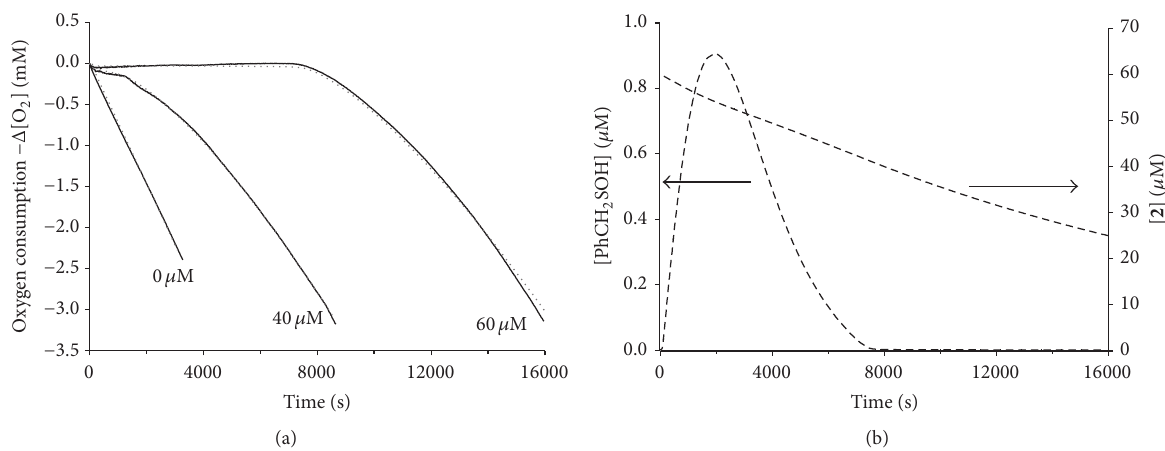
Figure 4: Analysis of autoxidation traces by the Gepasi software. (a) Experimental (solid lines) and simulated (dotted lines) O 2 consumption during the autoxidation of cumene in the presence of variable amounts of thiosulfinate ( 2 ). (b) Variations of the concentration of thiosulfinate ( 2 ) and sulfenic acid ( 3 ), obtained by simulation based on kinetic data determined in (a) at the concentration of 60 𝜇 m. Reprinted with permission from [45].